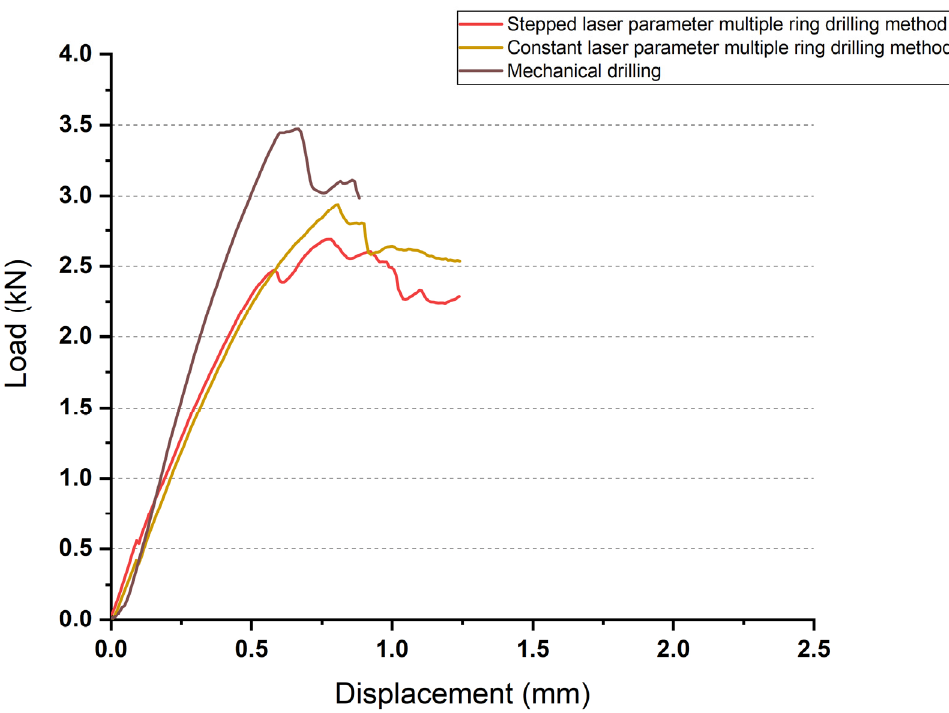
Figure 15. Evaluation trends of load versus displacement.